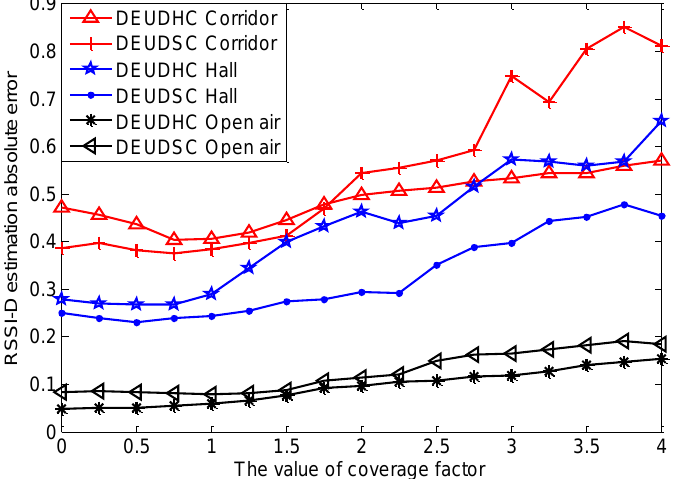
Figure 10. Changes in distance estimation error with coverage factor in three